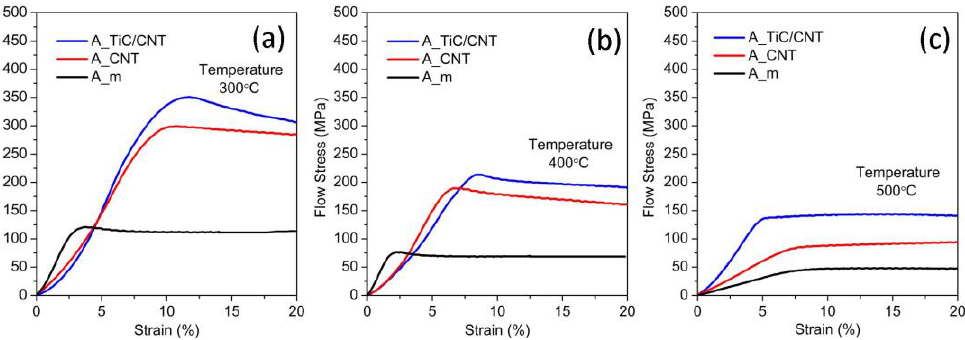
Figure 5. Compression flow stress curves at 300 °C ( a ), 400 °C ( b ), 500 °C ( c ) and strain rate 0.1 s −1 .